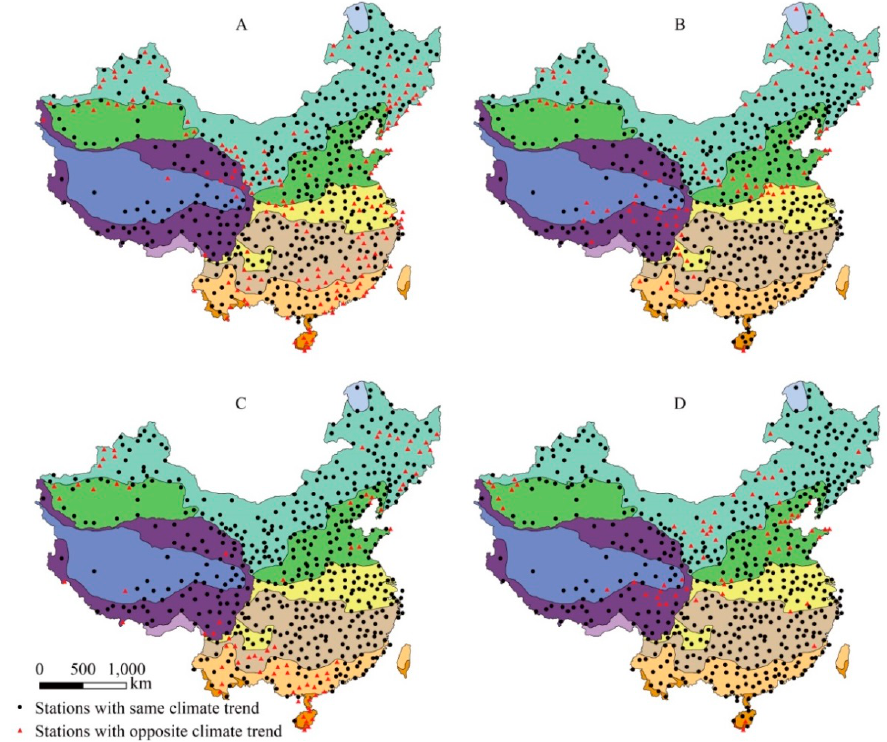
Figure 4. Climate trend of daily maximum temperature for January 1st ( A ), April 1st ( B ), July 1st ( C ) and October 1st( D ).